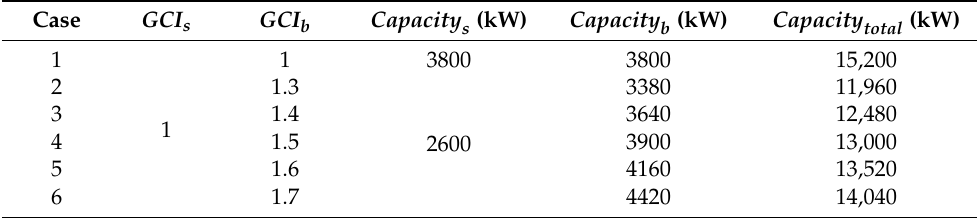
Table 4. Generator capacity by